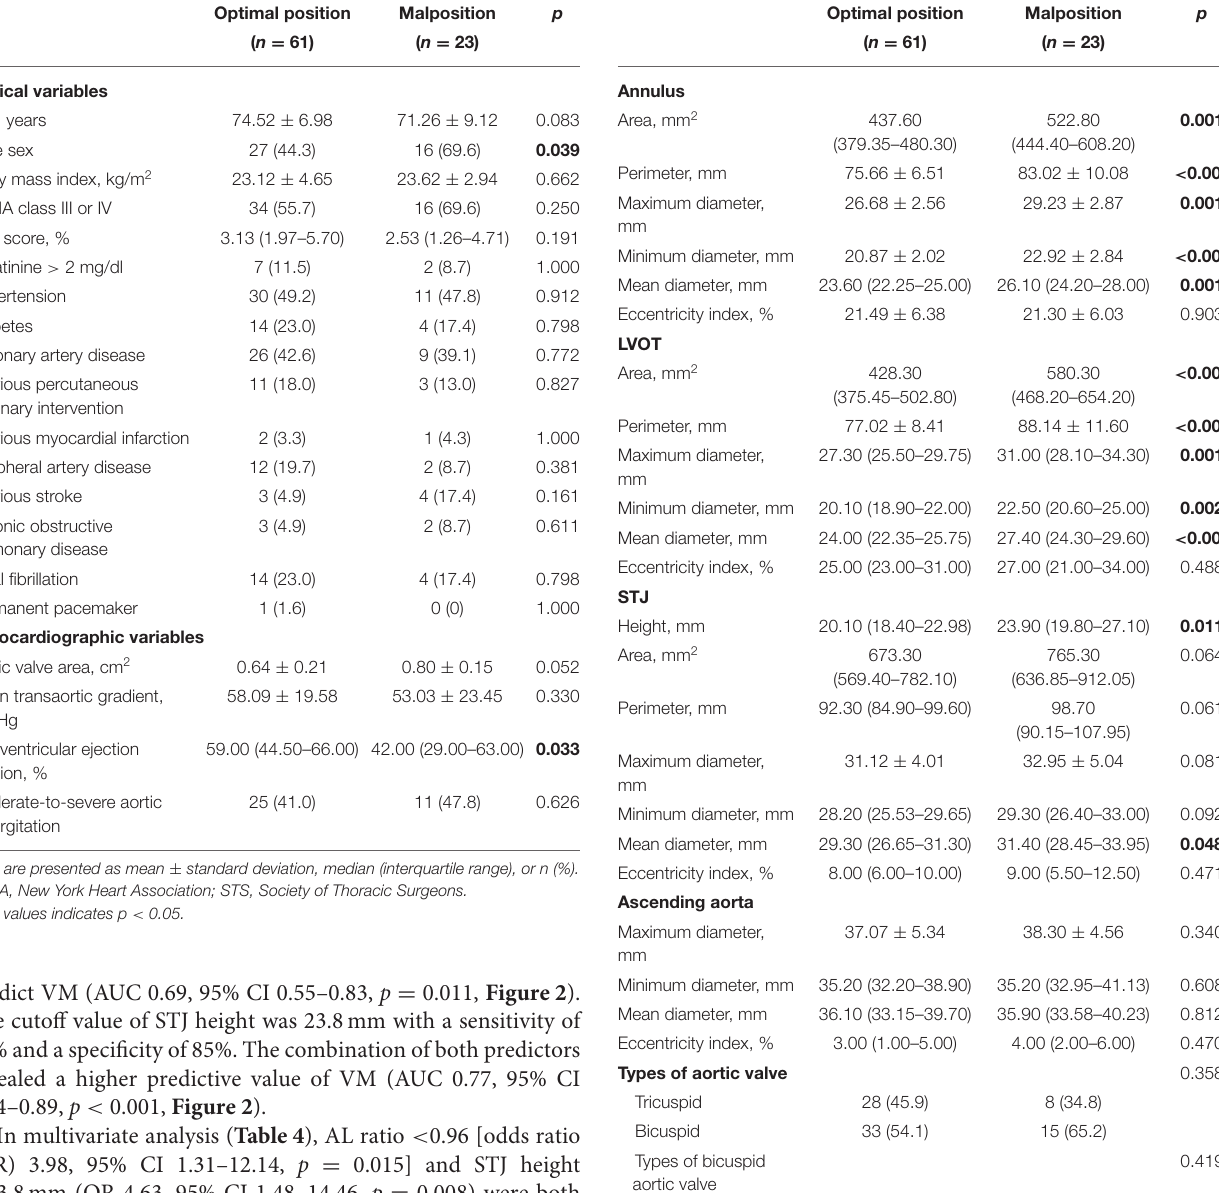
TABLE 1 | Baseline characteristics. TABLE 2 | MDCT